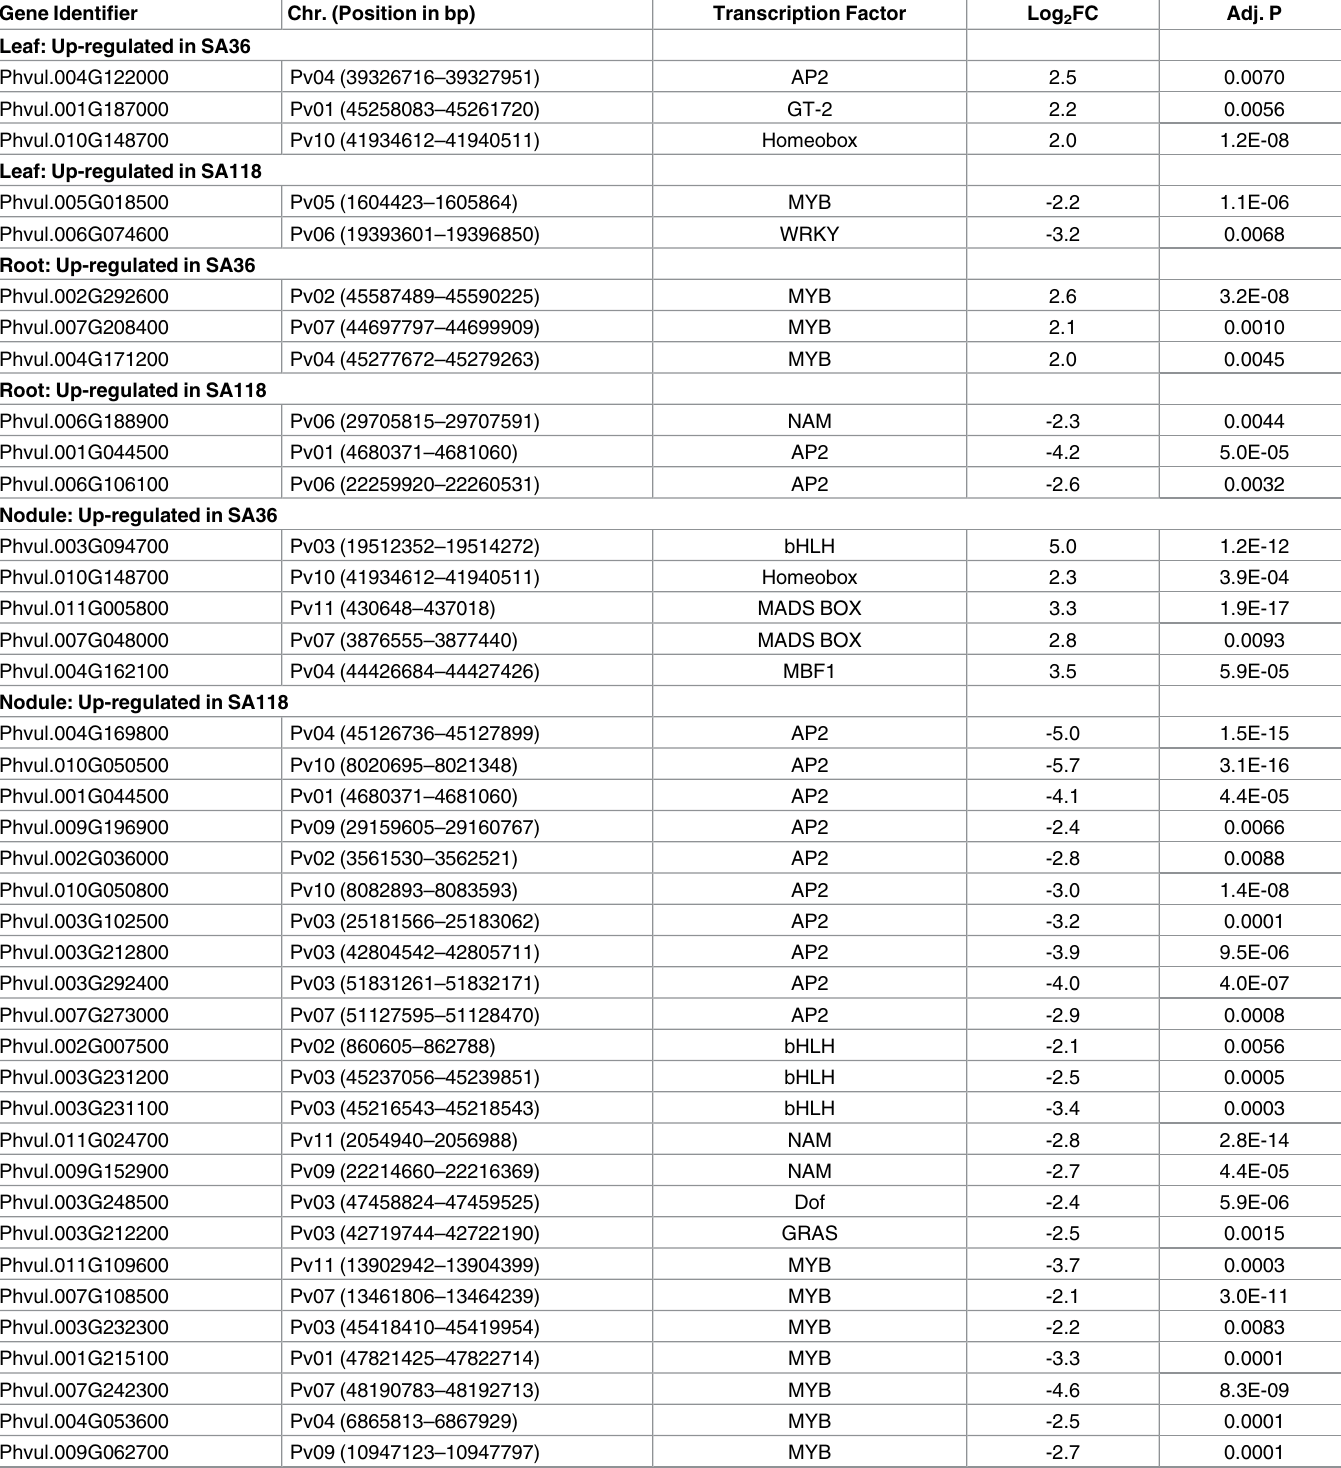
Table 2. Differentially expressedtranscription factors. These are transcriptionfactors with differentialexpressionbetweenSA36 and SA118 in leaf, root and noduleunder N-fixing condition, but were not differentiallyexpressedunder non-fixing conditions. Gene